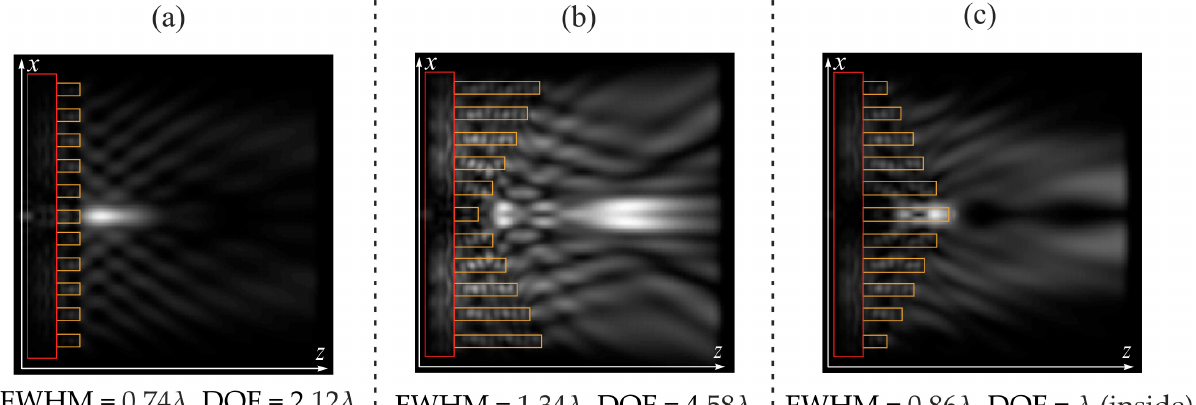
Figure 6. Two-dimensional diffraction pattern of the Laguerre–Gaussian mode (0,1) on variable-height annular gratings in the xz plane, total intensity: ( a ) standard diffraction axicon with a height h = 1.06 λ , ( b ) reverse annular grating with a height h from 1.06 λ to 3.71 λ , and ( c ) direct annular grating with a height h from 3.71 λ to 1.06 λ .